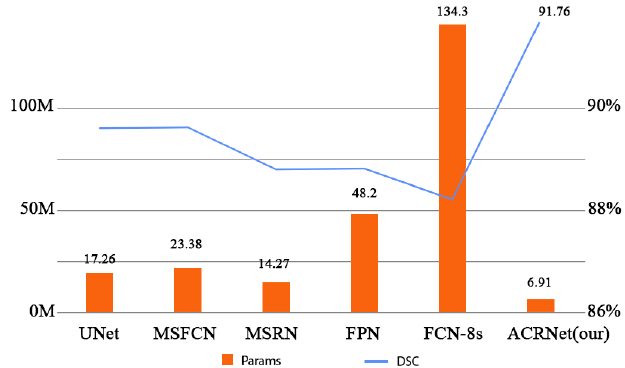
Figure 7. Comparison of Params and DSC between different models.